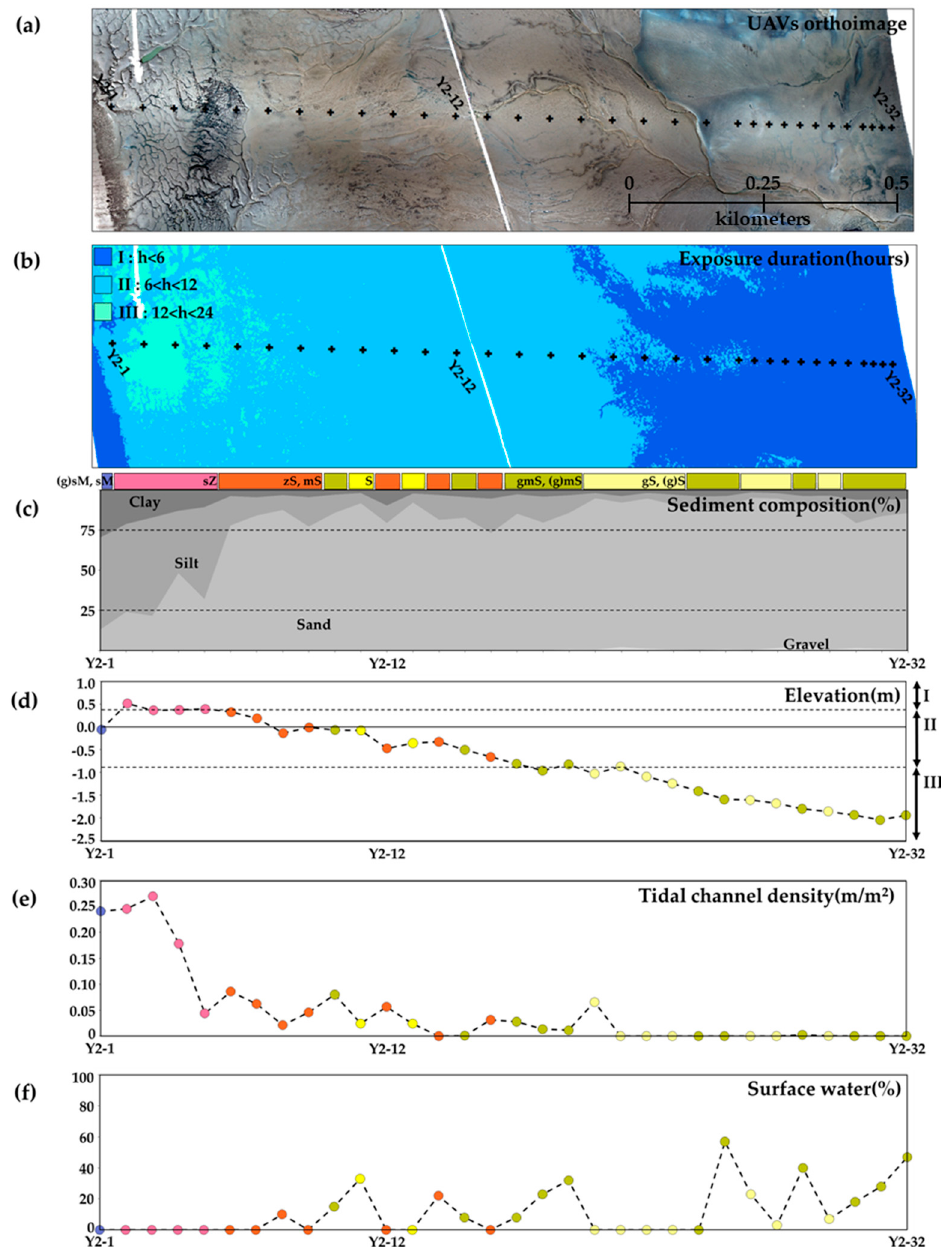
Figure 5. Correlation between sediment composition and depositional environment factors at line Y2. ( a , b ) show the tidal channel network and exposure duration extracted from UAV and tide height data; ( c ) indicates that the sediment type is related to the sediment composition, which controls the elevation, tidal channel density, and surface water ( d , e , and f , respectively).